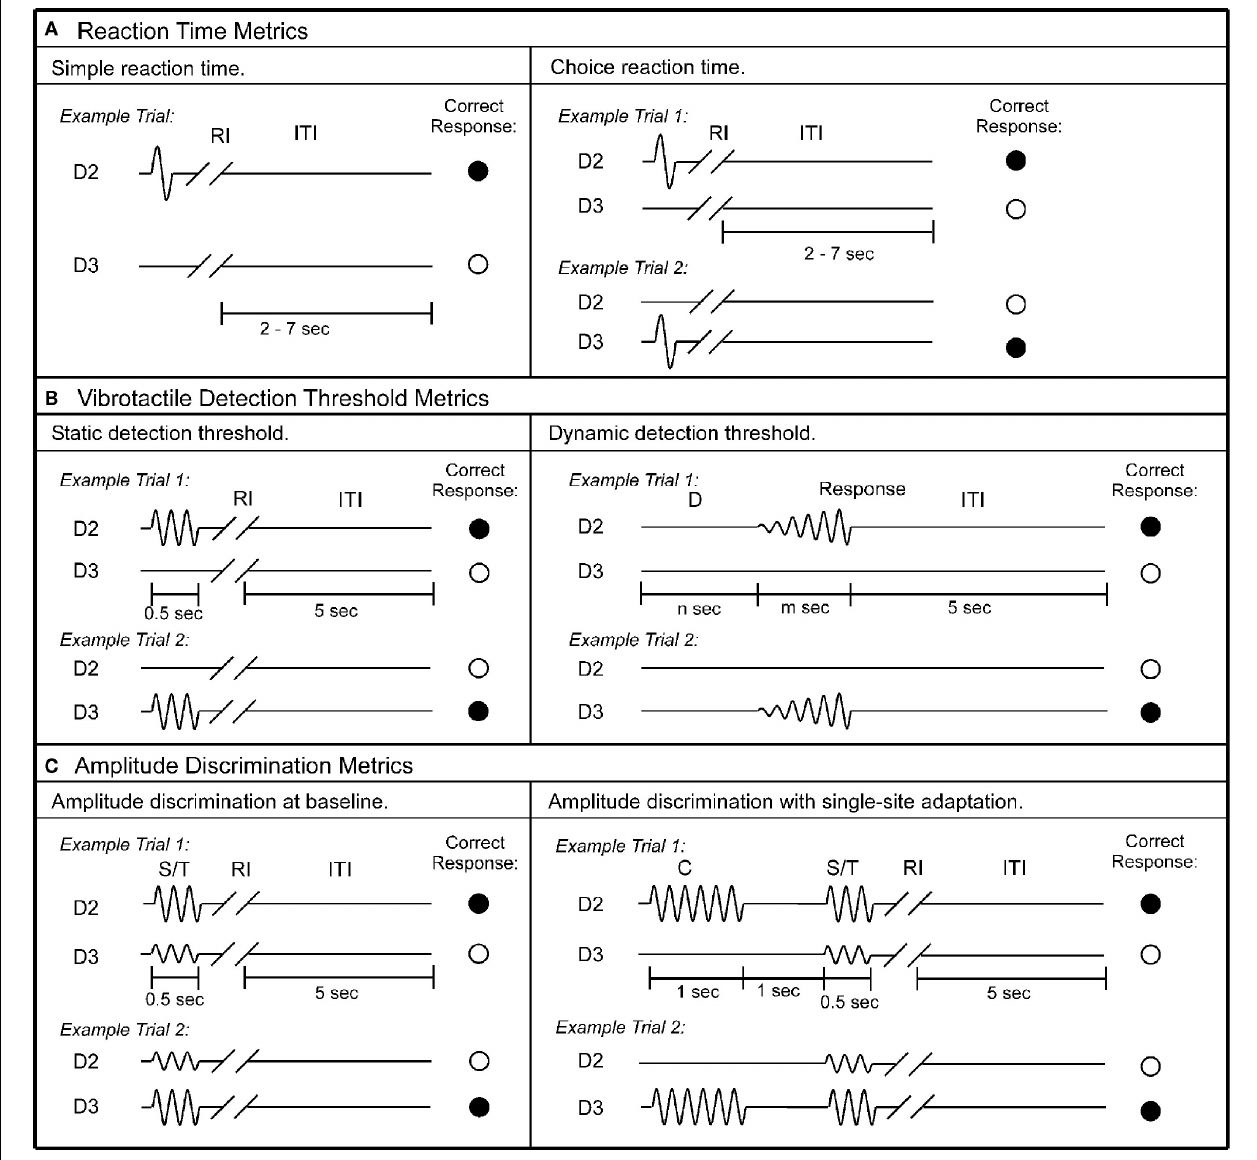
panel: during each trial of the dynamic detection threshold task, a delay period (D) ( n seconds = 0, 1.5, 2, or 3s) without any stimulation was applied. After the initial delay, a 25-Hz vibrotactile stimulus was delivered to either D2 or D3.The amplitude of the stimulus was initiated from zero and increased in steps of 2 μ m/s.The stimulation was terminated with subject response to the perceived stimulus. (C) Amplitude discrimination metrics. Left panel: during each trial of the amplitude discrimination task, two 25Hz vibrotactile stimuli – the standard (S) and test (T) – were delivered simultaneously for 0.5s. Subject was instructed to choose the stimulus that was perceptually larger. Right panel: the amplitude discrimination task was conducted after single-site adaptation. During each trial, a 25-Hz conditioning stimulus (C) was delivered for 1s prior to the presentation of the test and standard